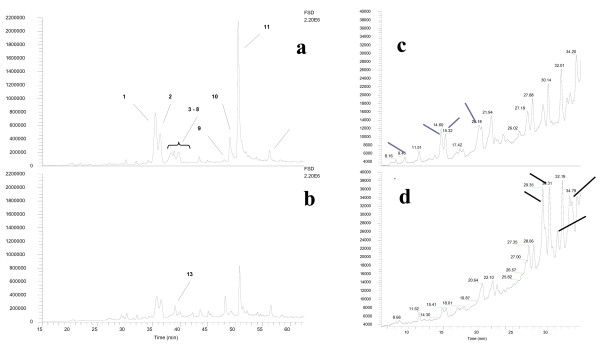
MS trace of berry extract and CARE. Comparison of undigested raspberry extract (a) and CARE (b) samples by LC-MS/MS, peaks 1 – 12 have been characterised (Table 1). Expanded area of LC trace of whole raspberry extract (c) and CARE (d). Arrows in c denote peaks that are reduced by in vitro digestion, arrows in d denote peaks that increase in abundance or are only present in the digested sample.